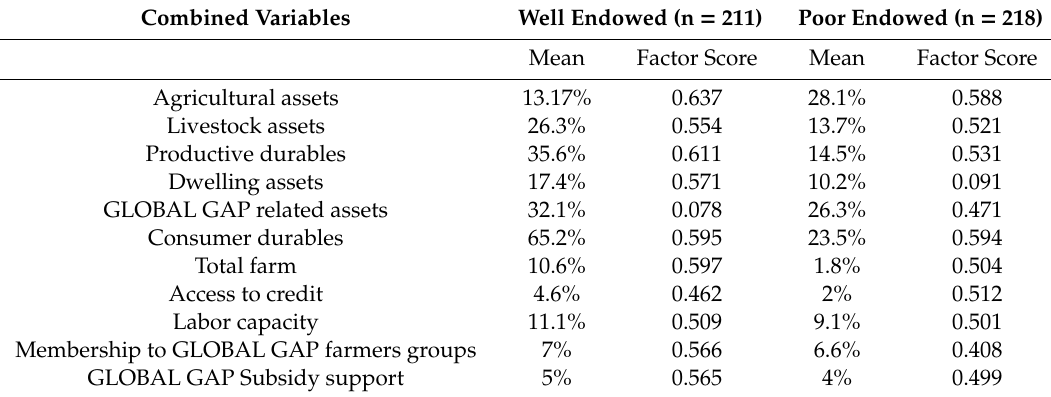
Figure 2. Sample Mean of the Standardized Wealth Index. Source: Authors’ survey, 2017. Table 2. Household Wealth indicators by Wealth Category.